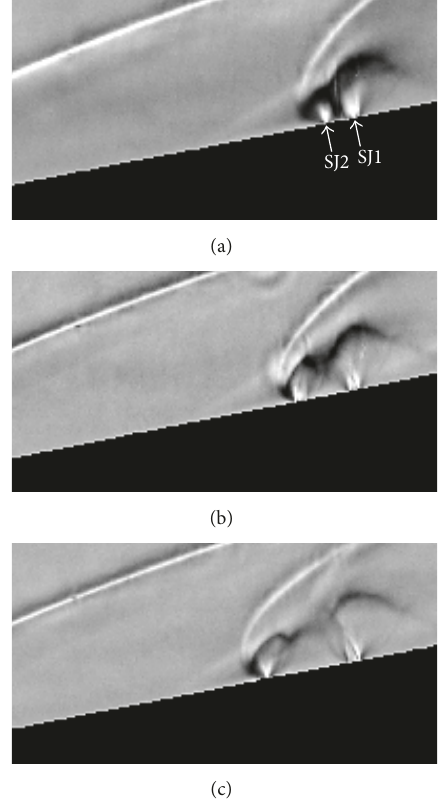
Figure 11: Schlieren photographs for the tandem dual injections at (a) 𝑆 𝑥 = 3.36 D , (b) 𝑆 𝑥 = 6.72𝐷 , and (c) 𝑆 𝑥 = 10.1𝐷 .